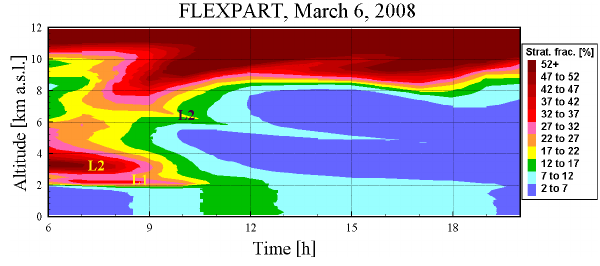
Fig. 2. FLEXPART stratospheric fractions for the period shown in Fig. 1, obtained from twenty-day Figure 2. FLEXPART stratospheric fractions for the period shown retroplume calculations in Fig. 1, obtained from 20-day retroplume Please, print Fig. 2 just below Fig. 1, if possible, all two columns wide.